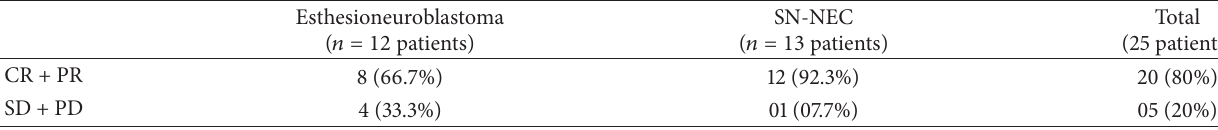
Table 4: Response rates according to histological type.